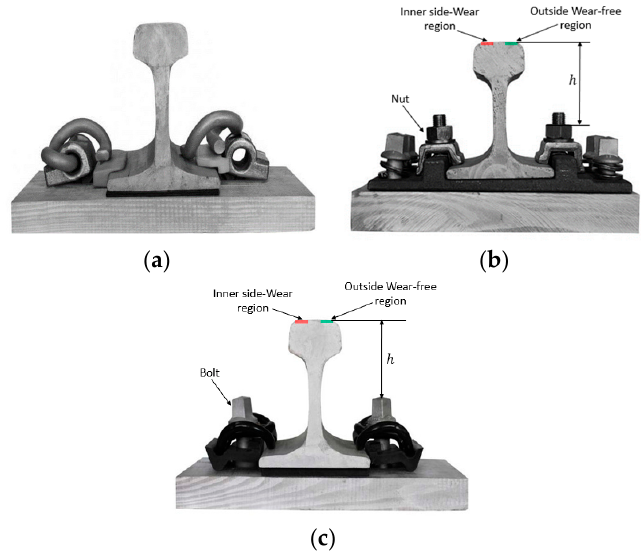
Figure 1. Rail fastener types: ( a ) Bolt-free fastener; ( b ) nut-fastening fastener; ( c ) bolt-fastening fastener.